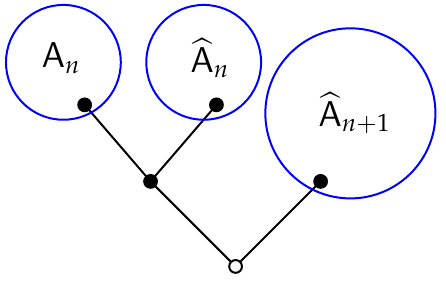
Figure 2. Images of A n , (cid:98) A n and (cid:98) A n + 1 represented in the tree diagram of T n + 2